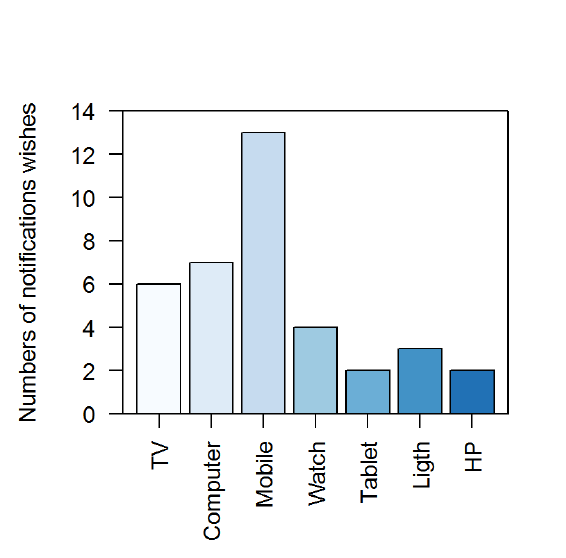
Figure 3. Numbers of participants wishes per support to be notified about environmental events